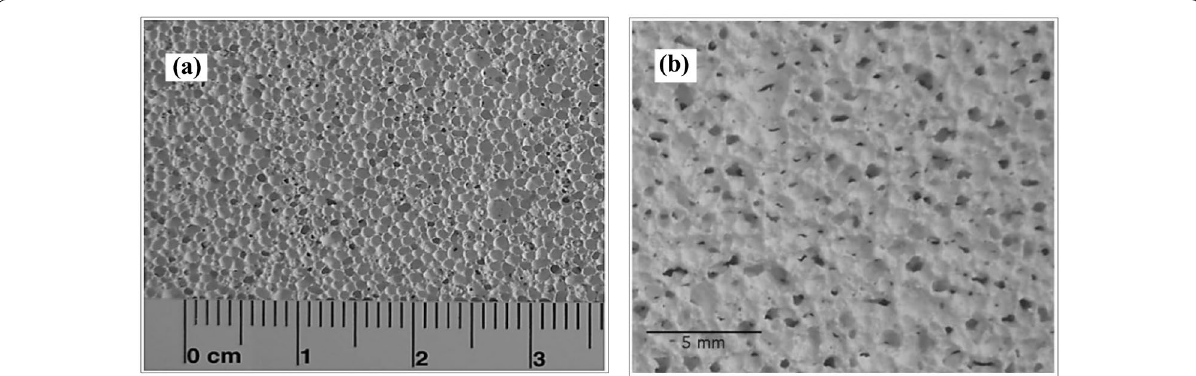
Fig. 13 Pore structure of a AAC sample and b expanding crack structure of an AAC sample made with aluminum powder as expanding agent (Schober,